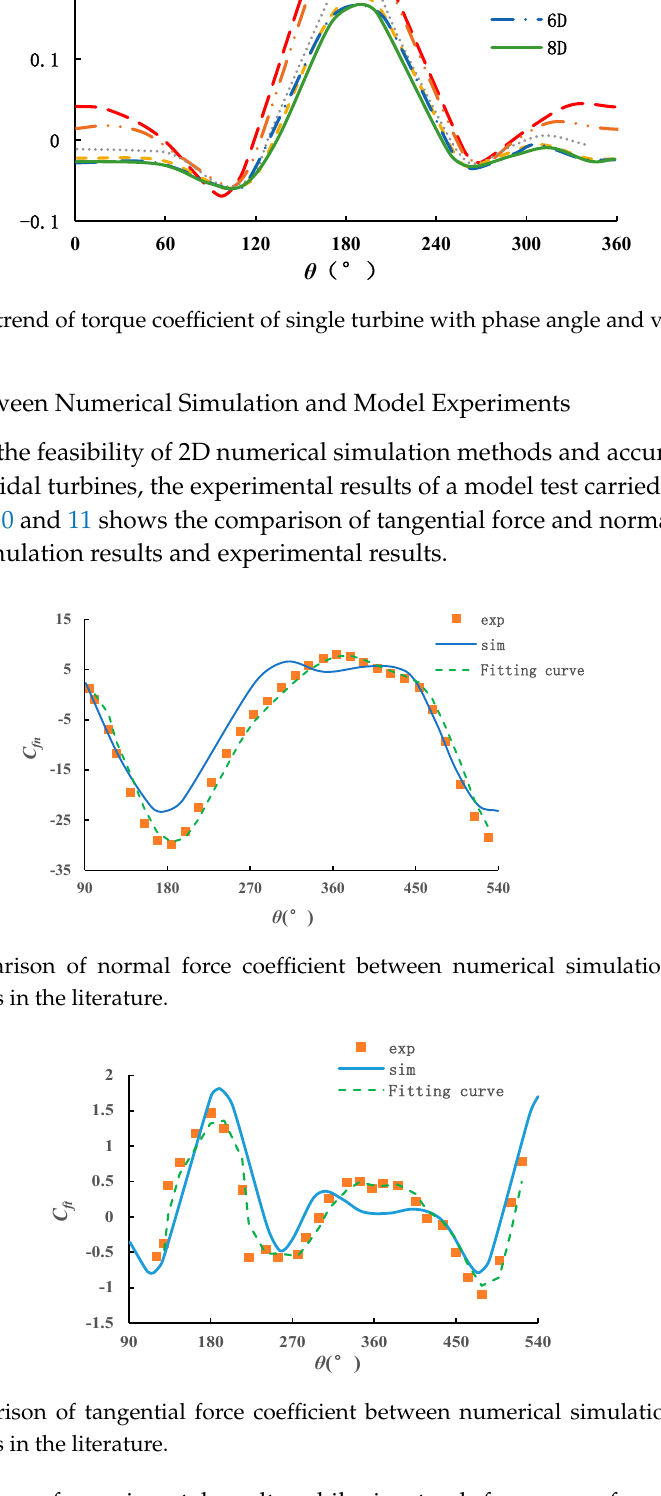
Figure 8. Variation trend of torque coefficient of single turbine with phase angle and varying D w for slip wall.